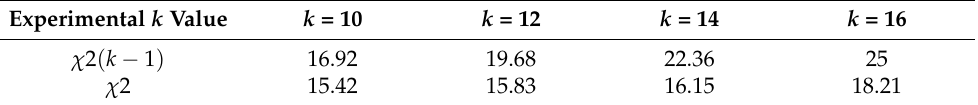
Table 1. Look-up Table χ 2 ( k − 1) value and experimental χ 2 value comparison. Experimental k